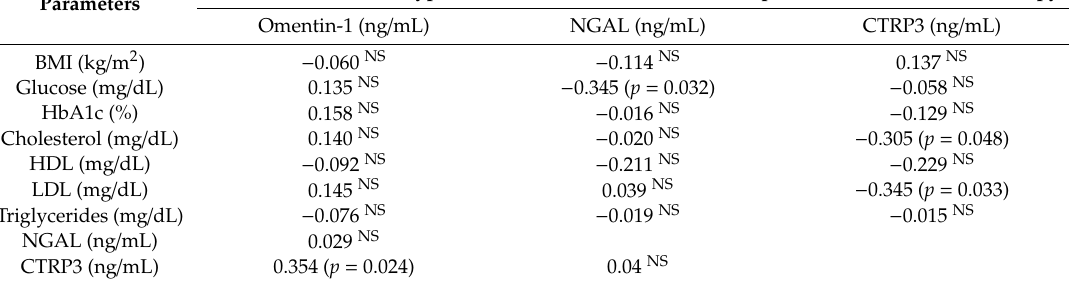
Table 3. Correlation between plasma concentration of the adipocytokines and the body mass index, and carbohydrate-lipid metabolism parameters in obese patients with type 2 diabetes before the implementation of insulin therapy and after 6-month